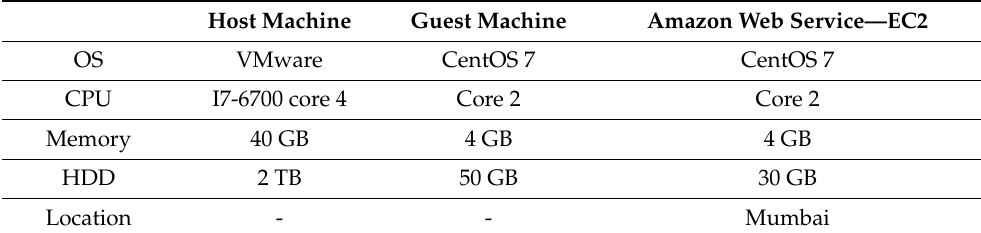
Table 1. The specifications of the cloud server, the host and the guest machines.